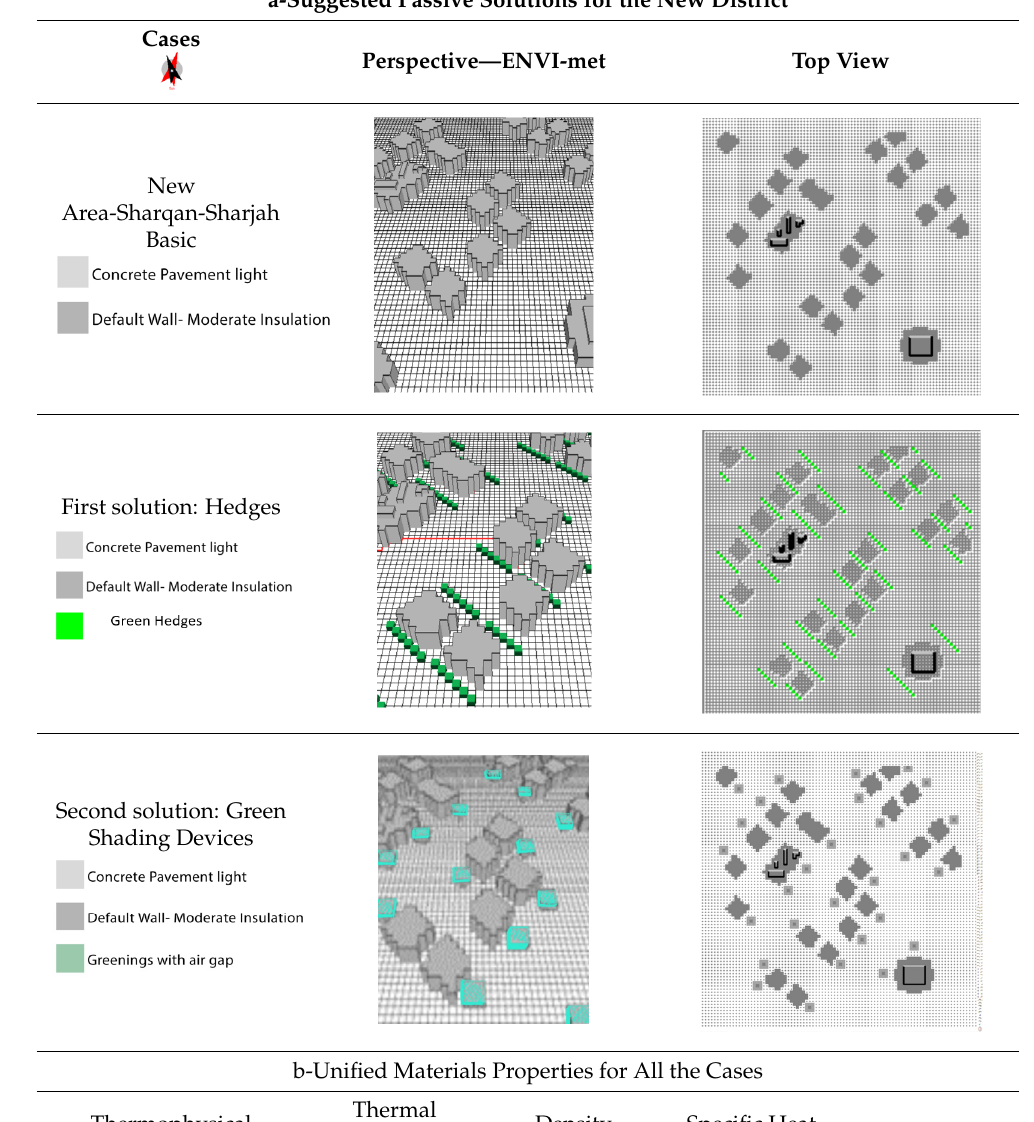
Table 5. The suggested passive solutions with the unified materials properties for the new district. a-Suggested Passive Solutions for the New District Cases